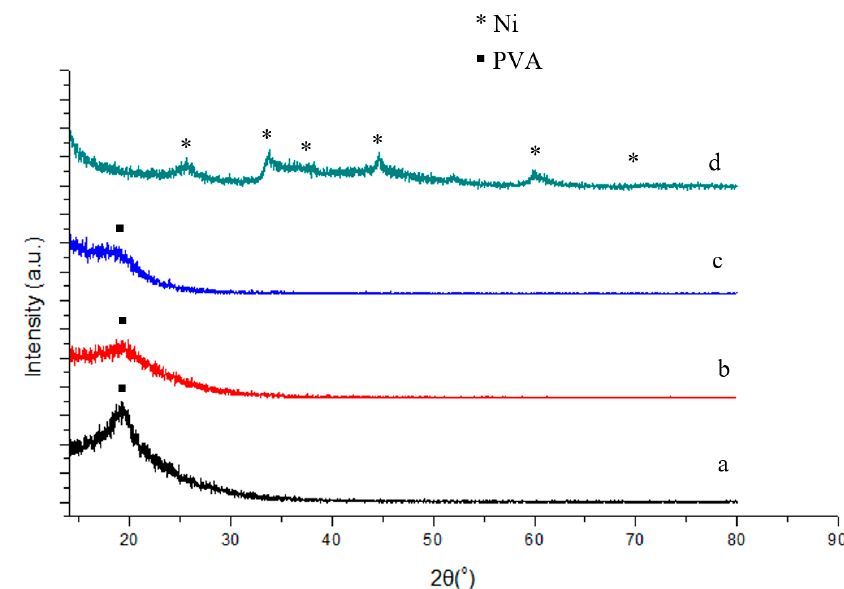
Figure 3. XRD patterns for PVA gel containing ( a ) 0% Ni; ( b ) 1.5% Ni; ( c ) 2.3% Ni; and ( d ) pure Ni nanoparticles.